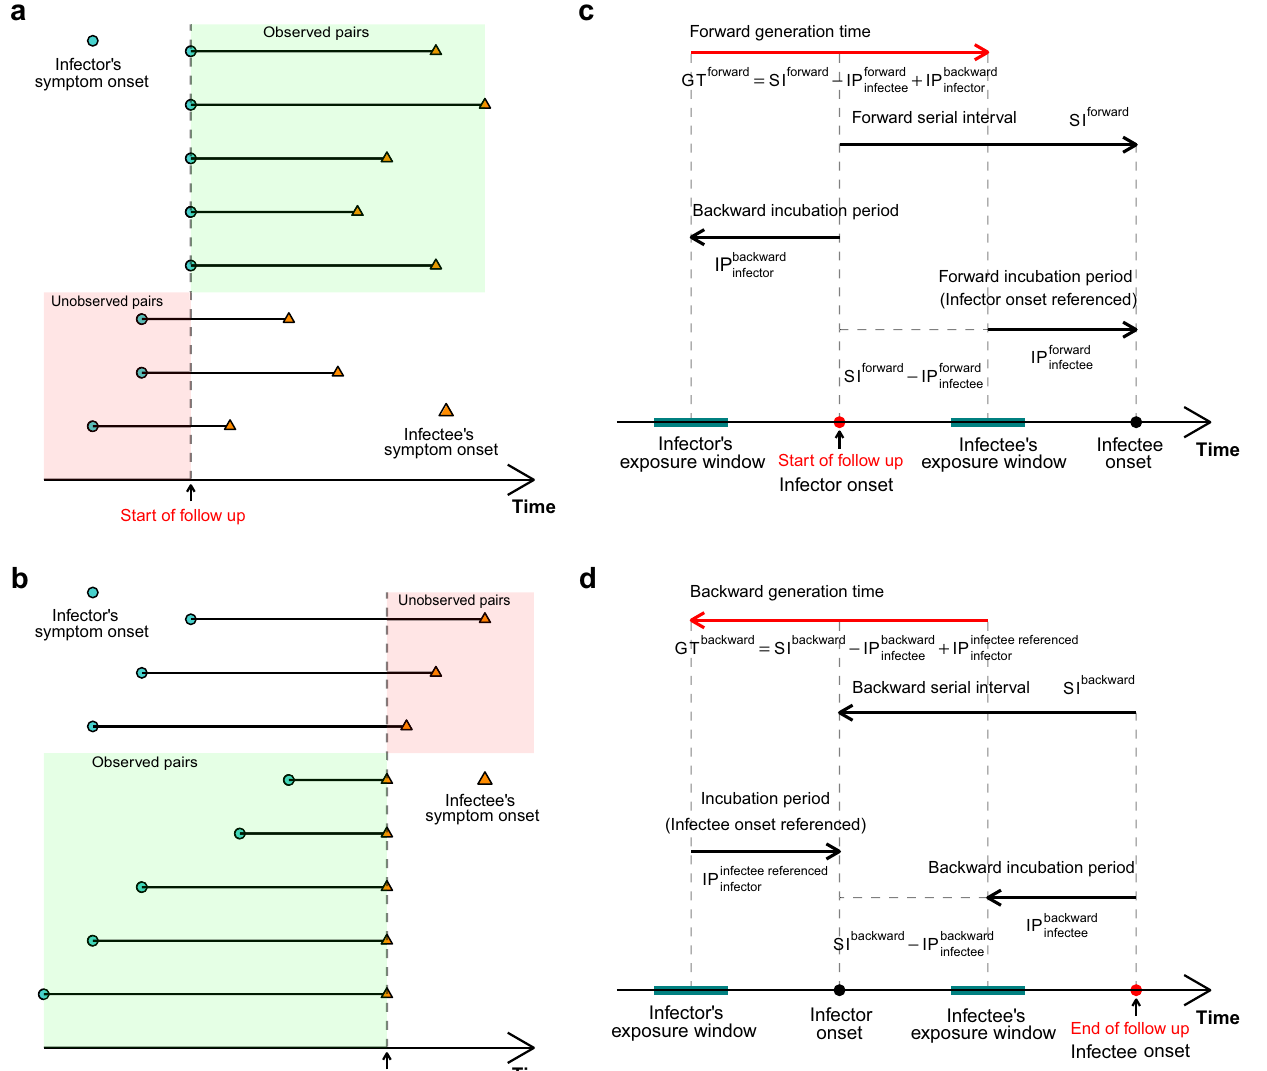
backward schemes (as presented in pink regions). c Inferential framework pre- sented for forward GT. d Inferential framework presented for backward GT.